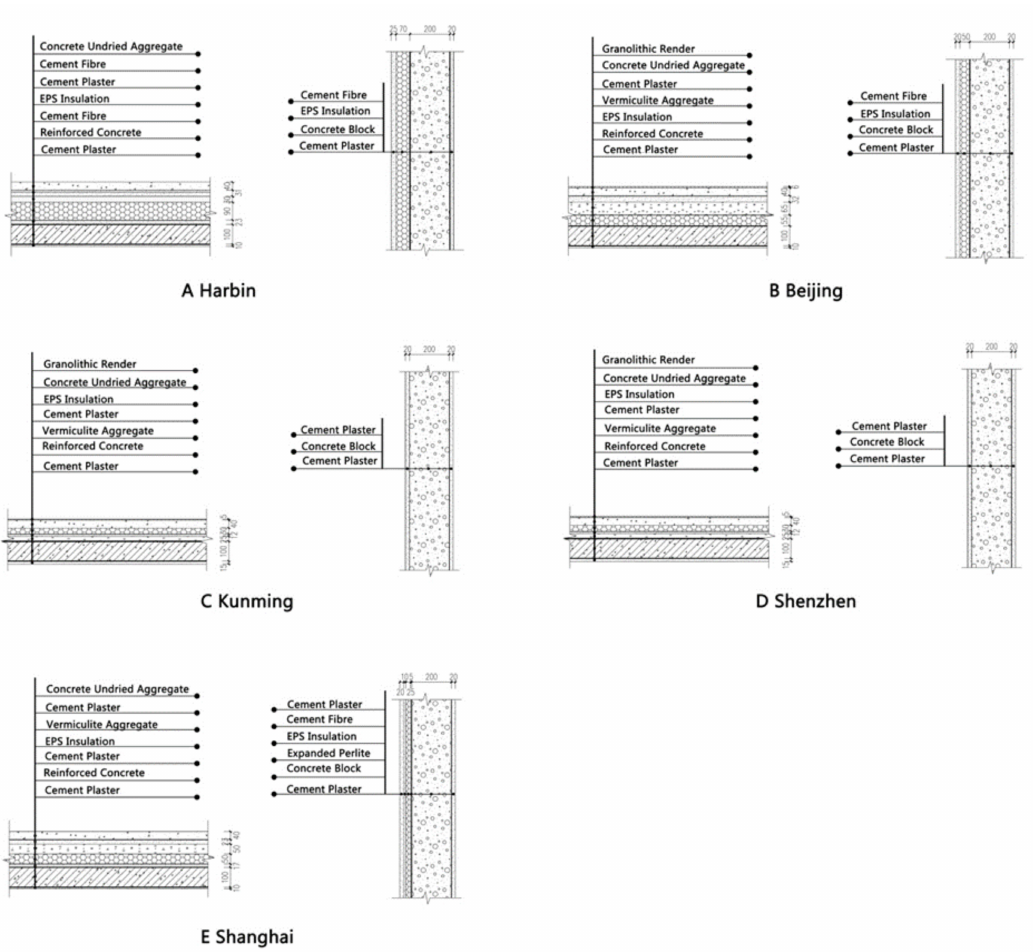
Figure 4. External wall and roof designs of the RC building in the five cities.